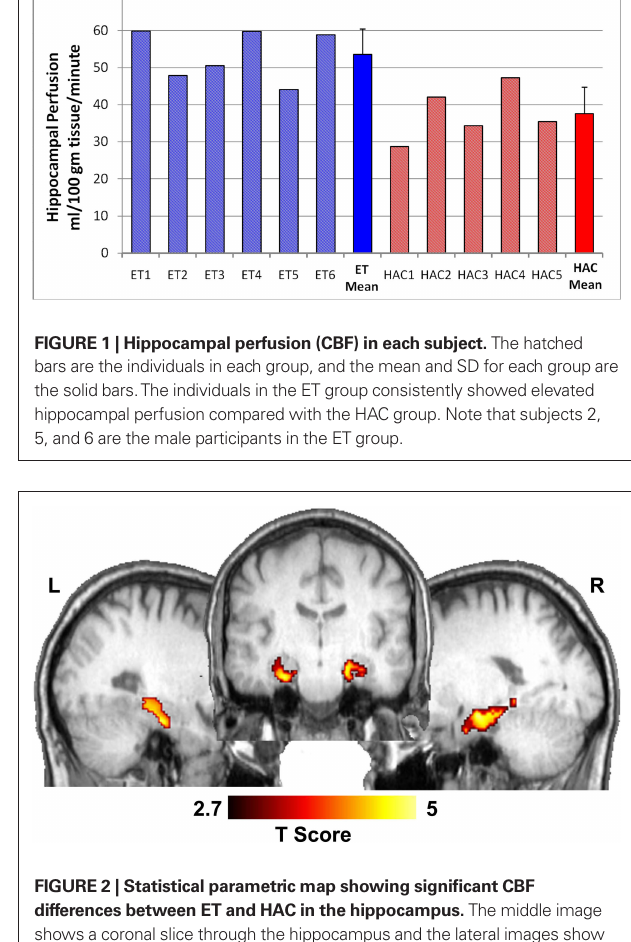
FIguRe 2 | Statistical parametric map showing significant CBF differences between eT and HAC in the hippocampus. The middle image shows a coronal slice through the hippocampus and the lateral images show sagittal sections through the left and right hippocampi.